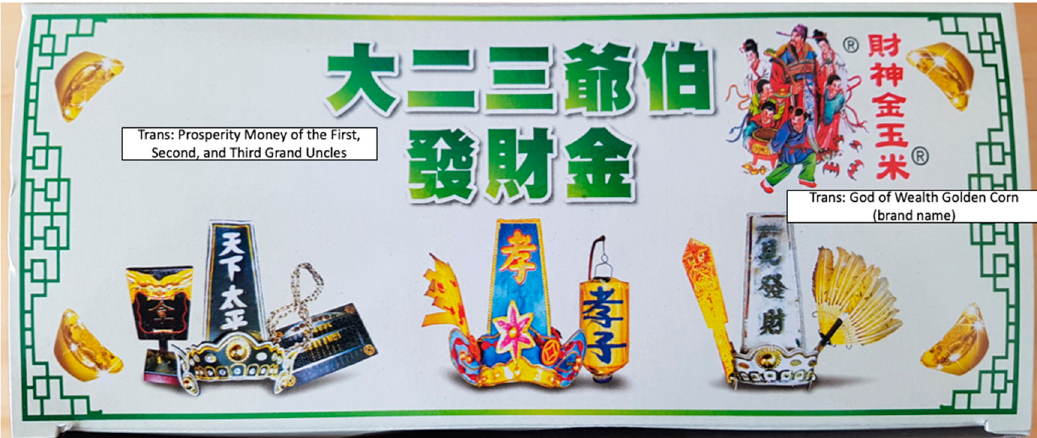
Figure 4. Cover of the “Prosperity Money” box (Source: Author).